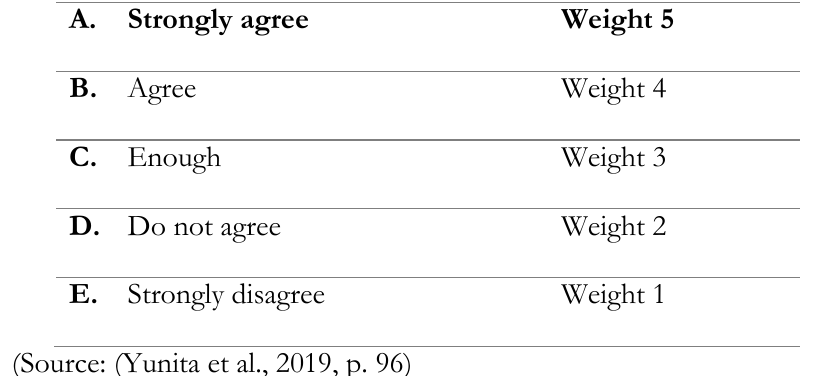
Table 1. Collecting data using a Likert Scale